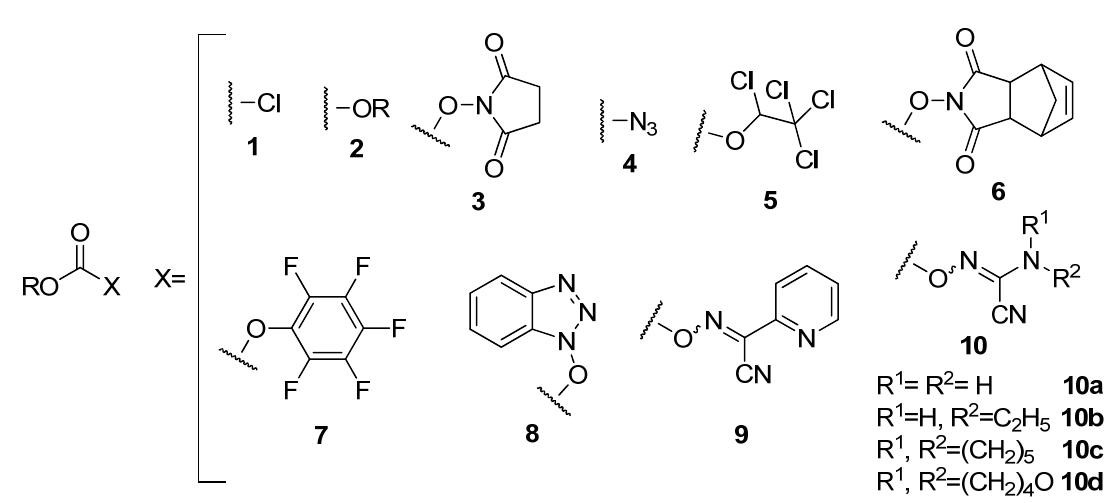
Figure 1. Structure of carbonates